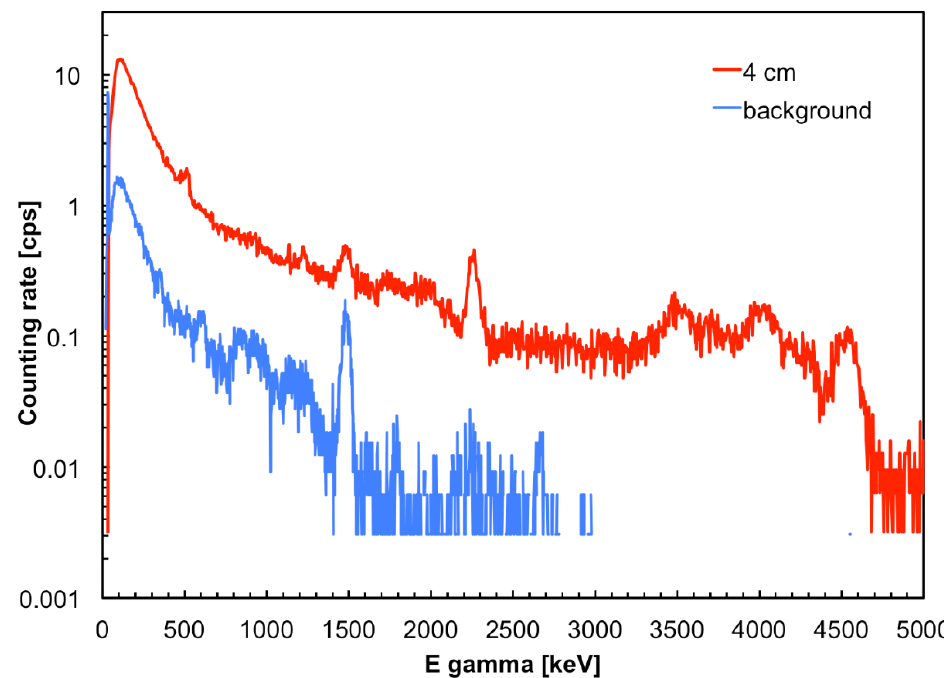
Figure 19. Energy spectrum of the gamma-rays emerging from the source box at 4 cm distance, and of the environment background.